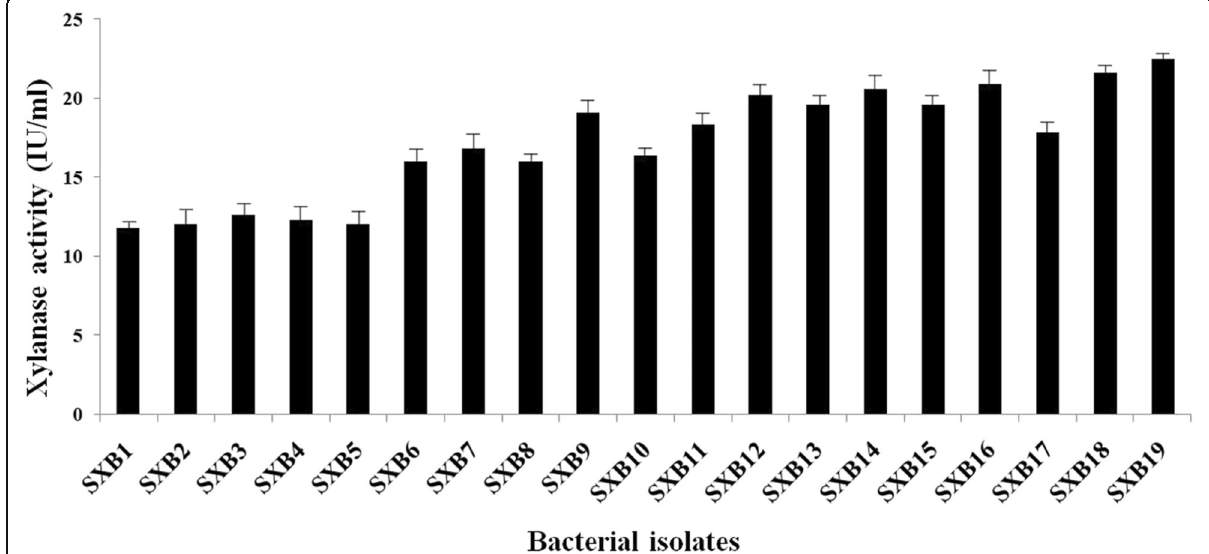
Fig. 2 Xylanase activity of bacteria using dinitrosalicyclic acid (DNS) method